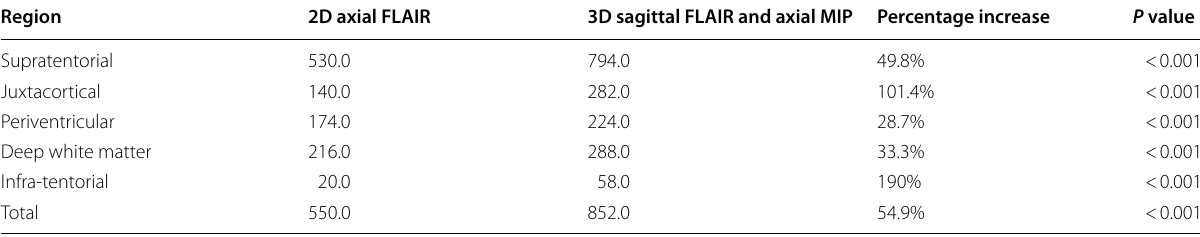
NB: Percentage increase was calculated by computing the difference between the 3D and 2D total counts and dividing that difference to the 2D total count, then multiplied by100